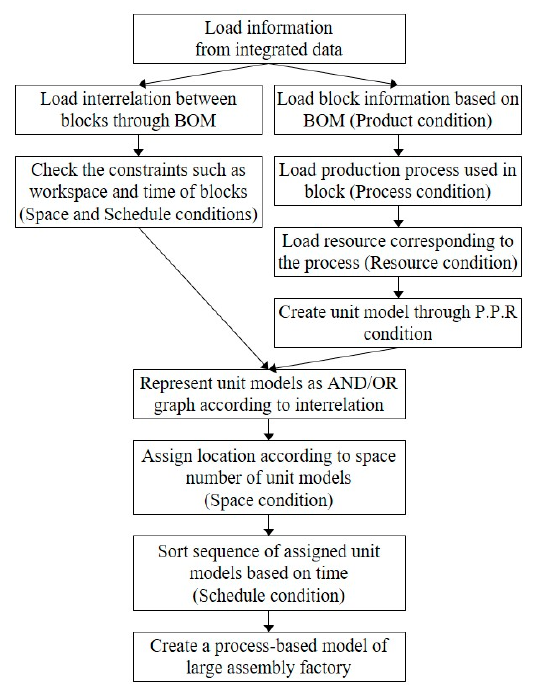
Figure 9. Flowchart of the integrated network process. PPR: product, process, and